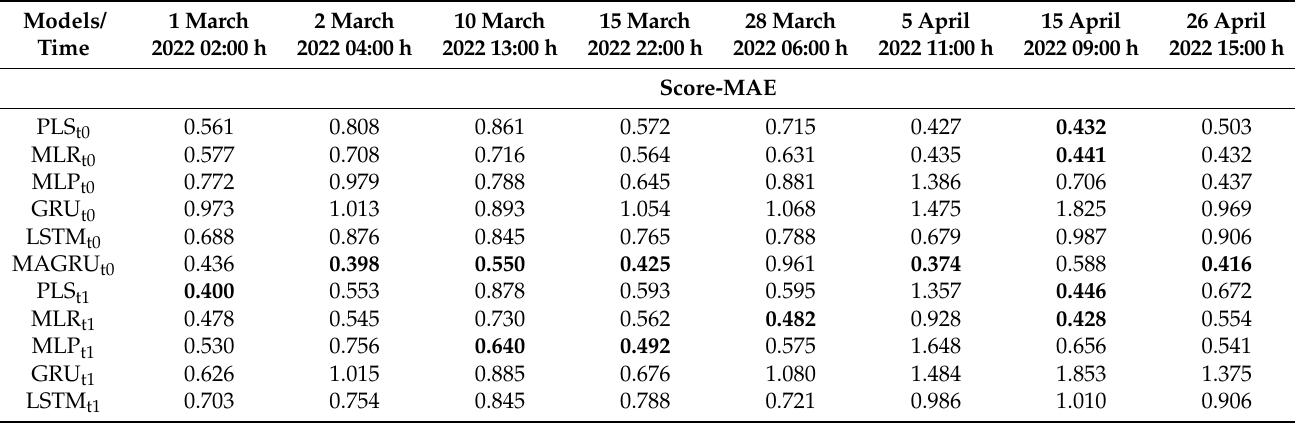
Table 3. Performance comparison of different